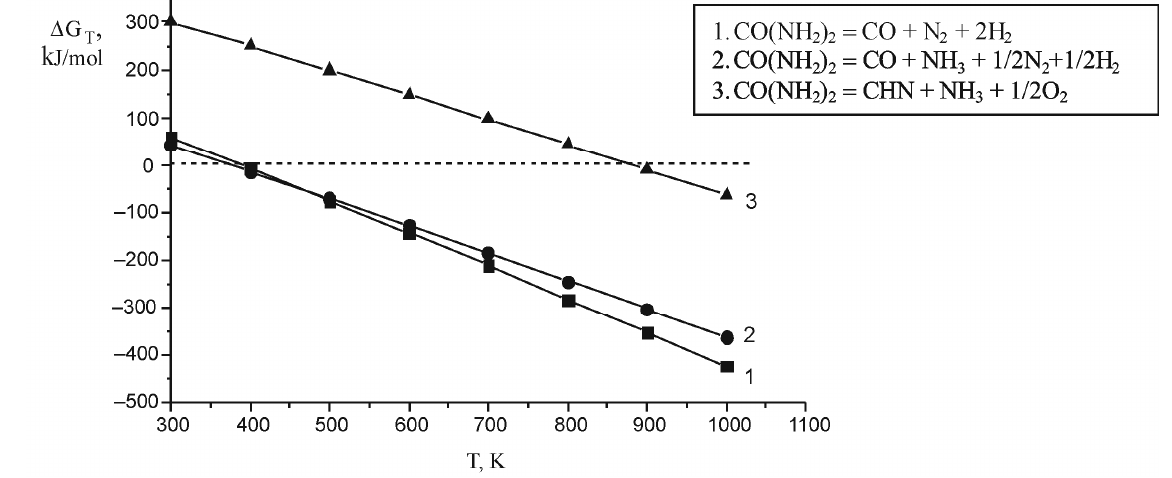
Fig. 2. The Gibbs’ energy value change dependency on temperature during carbamide pyrolysis according to the equations presented in the